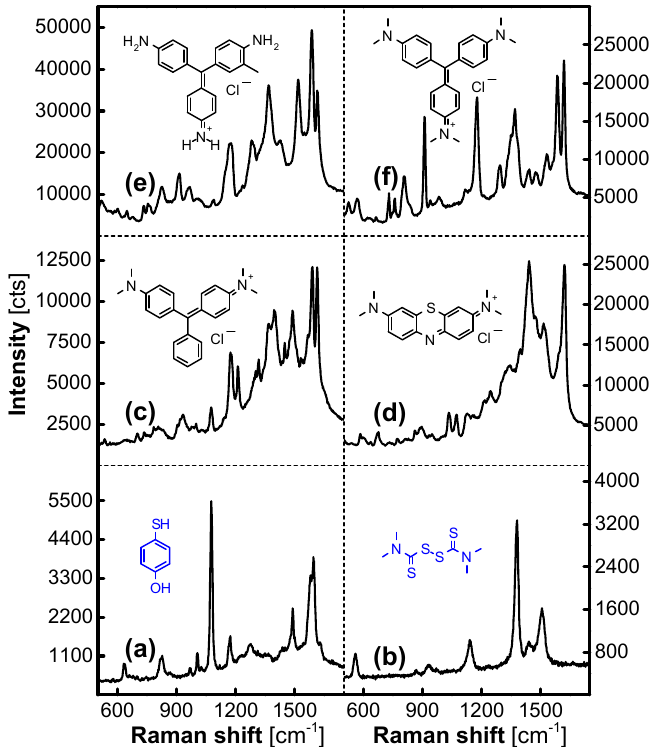
Figure 10. SERS spectra from a set of organic analytes (10 − 5 M) on AgNPs loaded on MF 3 synthesized in 8 h. ( a ) p -hydroxythiophenol (CAS: 637-89-8; pharmaceutical and dye intermediate); ( b ) tetramethylthiuram disulfide (CAS: 137-26-8; disinfectant, insecticide, and vulcanization accelerator in rubbers); ( c ) malachite green (CAS: 2437-29-8; dye and toxic antiseptic for aquaculture); ( d ) methylene blue (CAS: 7220-79-3; dye and drug); ( e ) basic violet 14 (CAS: 632-99-5; dye); and ( f ) crystal violet (CAS: 548-62-9; disinfectant and toxic antiseptic for aquaculture).